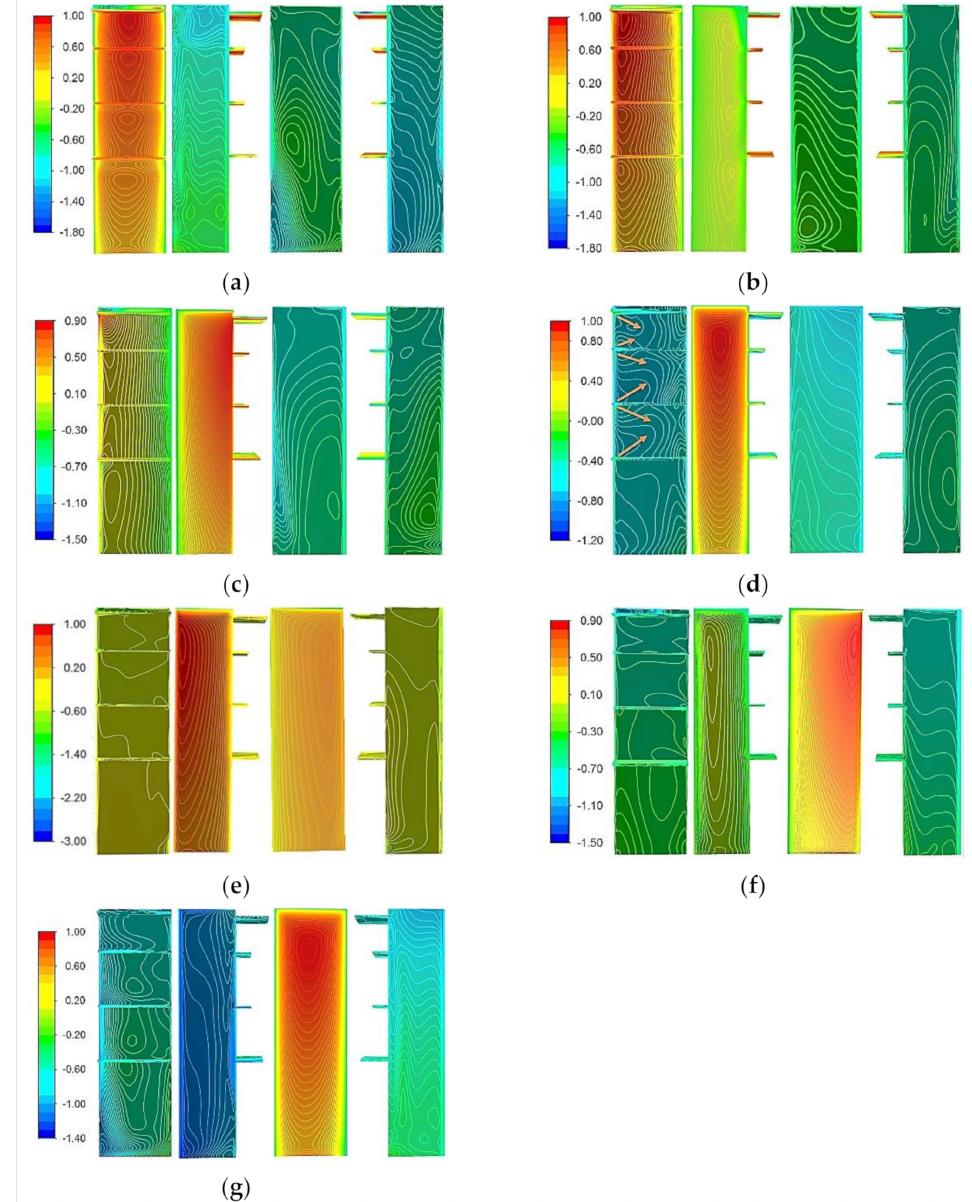
Figure 4. Distribution of wind pressure coefficients on building surfaces at different wind directions. ( a ) Case 1. θ = 0 ◦ ; ( b ) Case 2. θ = 30 ◦ ; ( c ) Case 3. θ = 60 ◦ ; ( d ) Case 4. θ = 90 ◦ ; ( e ) Case 5. θ = 120 ◦ ; ( f ) Case 6. θ = 150 ◦ ; ( g ) Case 7. θ = 180 ◦